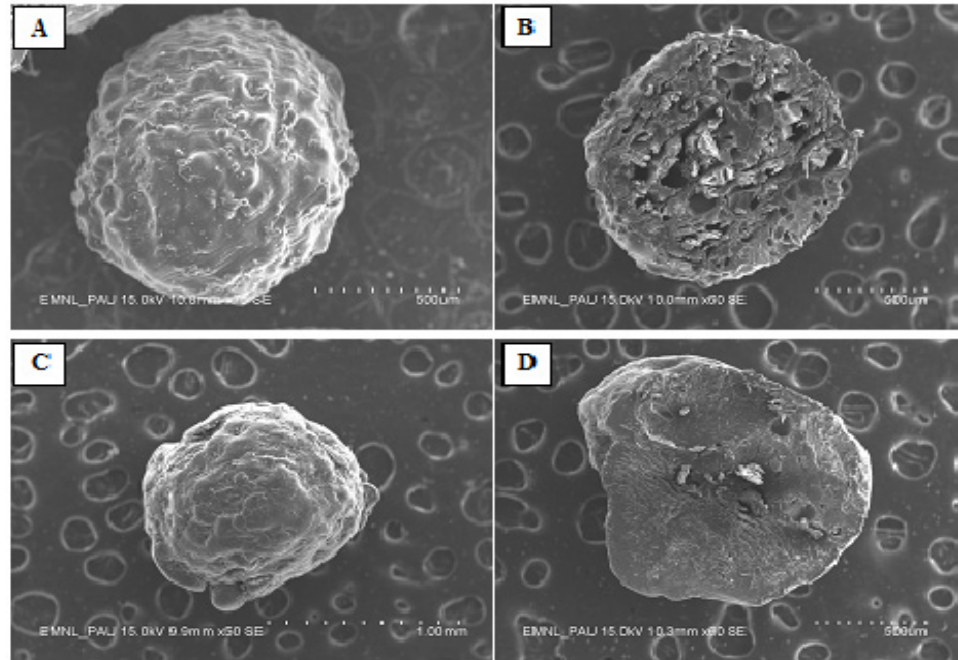
Figure 4. Microstructure of hydrogel beads (HBs): blank HBs ( A ) at 500 μ m, cross-sectional view of of blank HBs ( B ) at 600 µ m, CHBs ( C ) at 100 mm, and cross-sectional view of CHBs ( D ) at 600 µ m. blank HBs ( B ) at 600 μ m, CHBs ( C ) at 100 mm, and cross-sectional view of CHBs ( D ) at 600 μ m. CHBs, curcumin hydrogel CHBs, curcumin hydrogel beads.